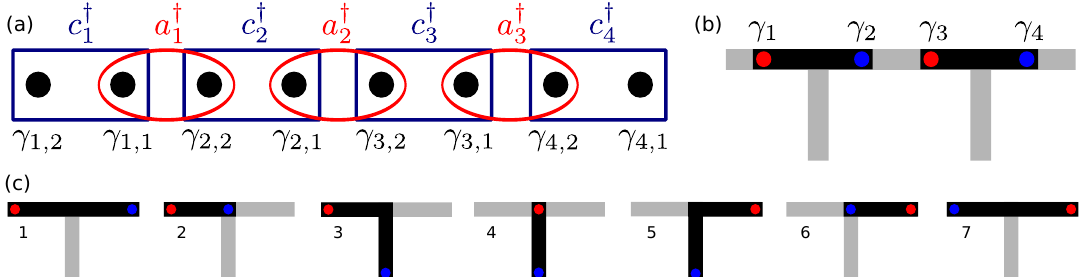
Figure 5. The qubits based on Majorana chain. ( a ) a schematic view of the single-particle eigenstates of Kitaev model in the special case of ∆ = t , µ = 0. The blue rectangles represent the sites, described with fermionic creation operators c † , the black circles represent Majorana operators, and the red ellipses i denote pairing two Majorana operators into a pair operator a † , being a fermionic creation operator; i ( b ) four Majorana zero modes (MZMs) in a network of nanowires. The gray and black denote the trivial and topological regions of the wires, respectively. The blue and red dots represent the MZMs. ( c ) braiding of two Majorana modes. The meaning of colors is the same as in ( b ). Although the MZMs are indistinguishable, we have labeled them with two different colors for